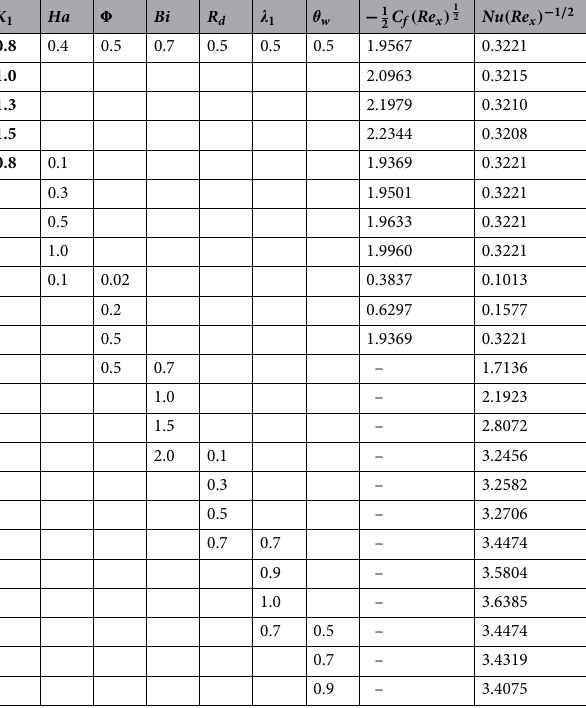
1 1 2 2 C f ( Re x )